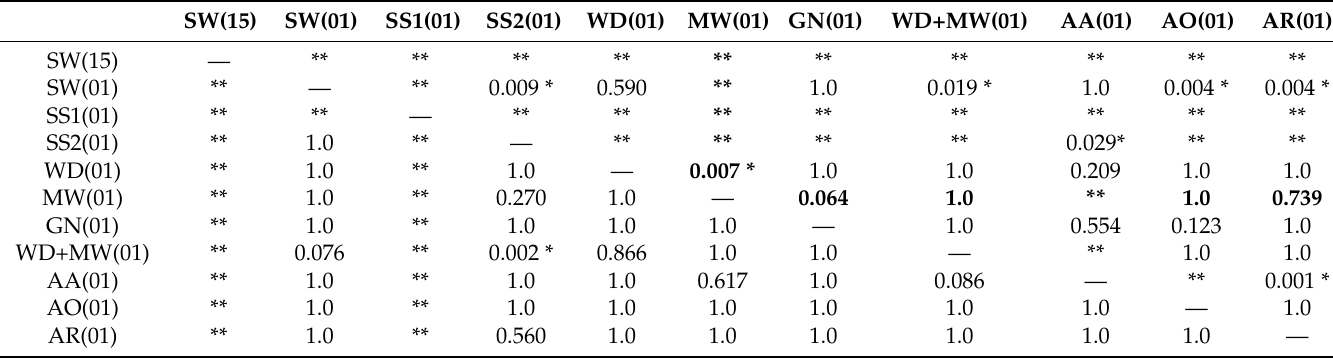
Table A10. Pairwise comparisons with Bonferonni correction for the Ninapro-DB1 dataset. The table shows the p -value of the comparison between the classification accuracy of the methods on the corresponding row and column. Values above the diagonal show the comparisons for R = 9 and below the diagonal for R = 1 (last and first row of Table A6, respectively). Values in bold correspond to the comparisons of the method with the highest classification accuracy in Table A6 (i.e.,